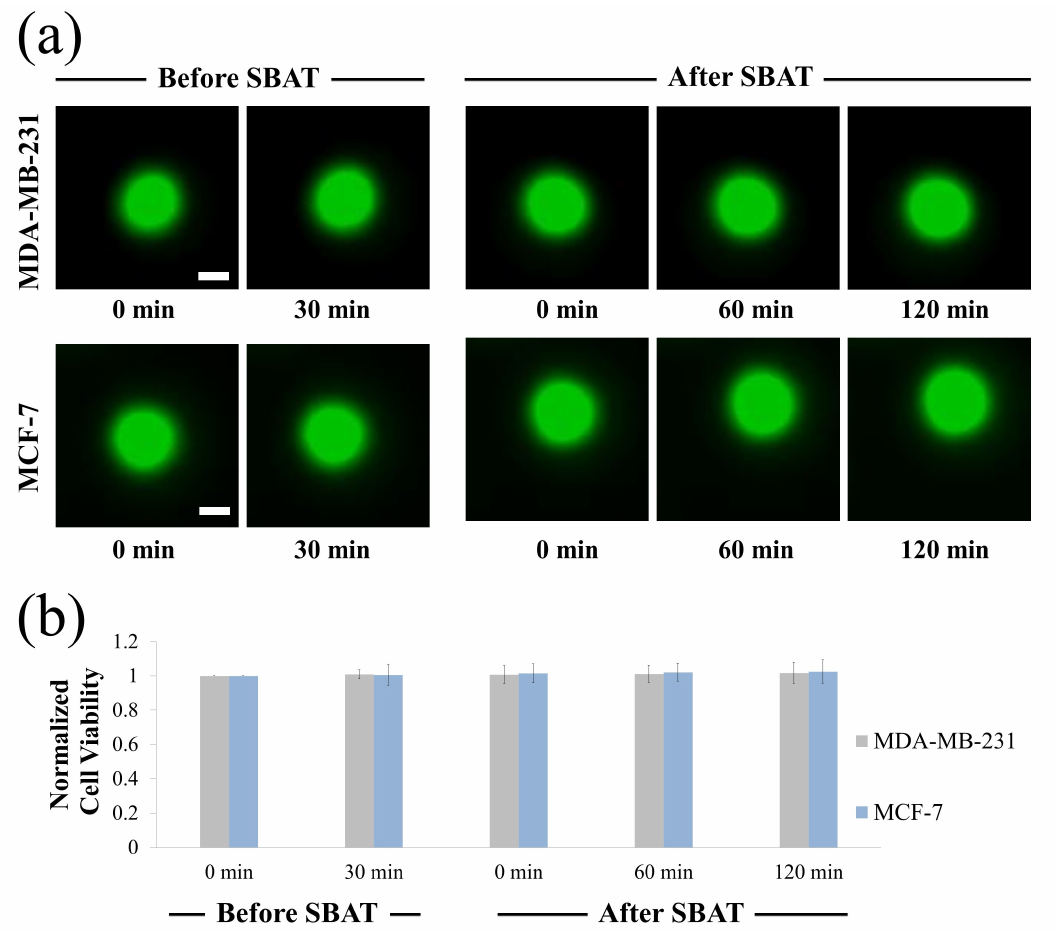
Figure 10. Cell viability assay upon single-beam acoustic tweezers (SBAT). ( a ) Fluorescence images of MDA-MB-231 and MCF-7 before SBAT (negative control) and after SBAT (experimental group). ( b ) Normalized fluorescence intensity of cells before and after SBAT. Error bars indicate standard deviations. The values at each cell line are the average of 20 samples. Scale bars indicate 10 µ m. There were no significant effects on the cell condition after